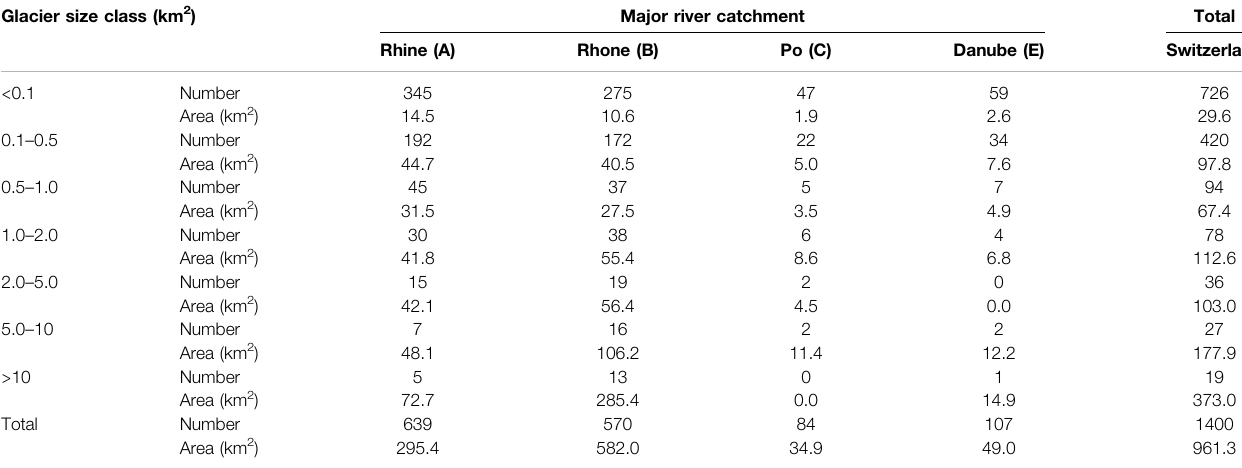
TABLE 3 | Number of glaciers and area mapped in the SGI2016, categorized in size classes and major river catchments. Glacier size class (km 2 )